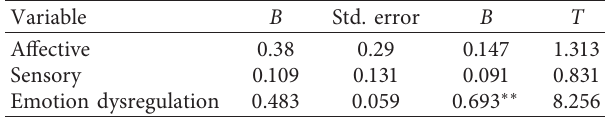
Table 3: Multiple linear